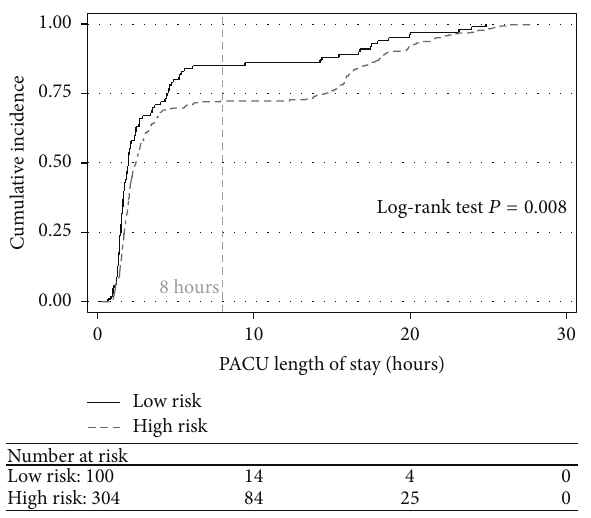
Figure 1: Cumulative incidence of discharge over time in the